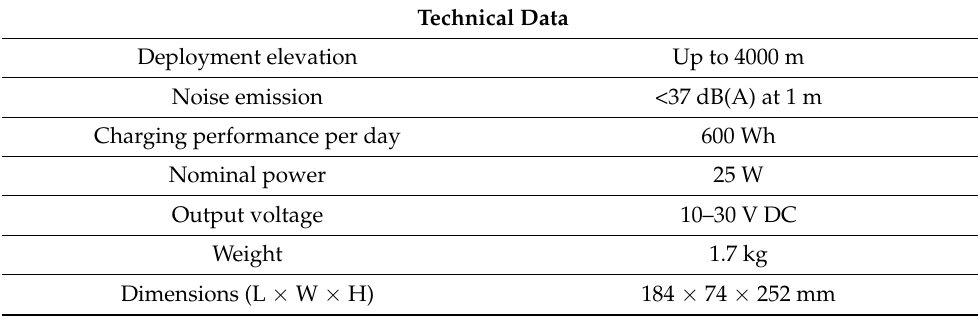
Table 4. Technical data of the JENNY 600S